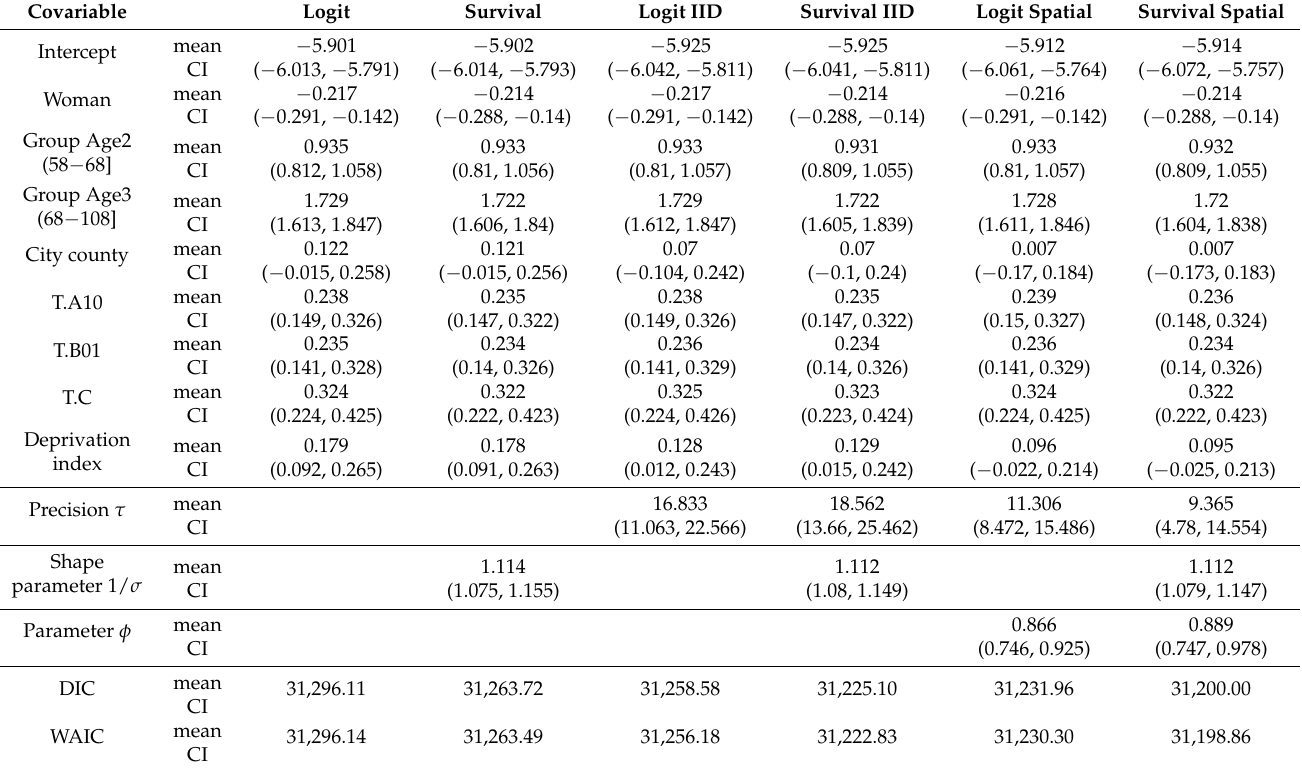
Table 2. Posterior summaries for the parameters and hyperparameter of the logistic regression model and survival model without random effects (LOGIT and SURVIVAL ), with random effects in terms of conditionally i . i . d random variables (LOGIT IID and SURVIVAL IID ), and spatially correlated random variables (LOGIT SPATIAL and SURVIVAL SPATIAL).